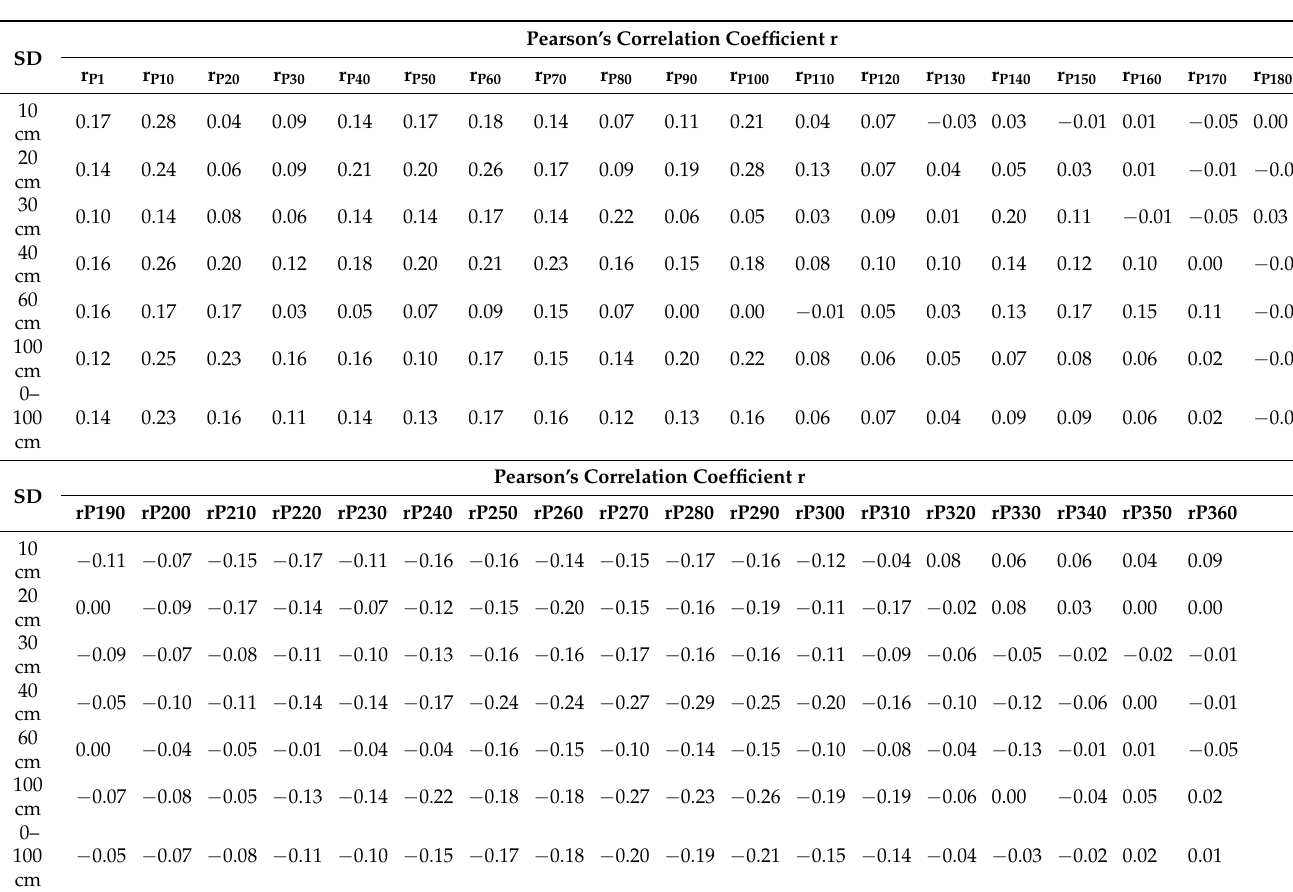
Table 1. Pearson’s correlation coefficient between soil moisture content of each layer and daily precipitation at different times in the arbors forest land (SD: soil